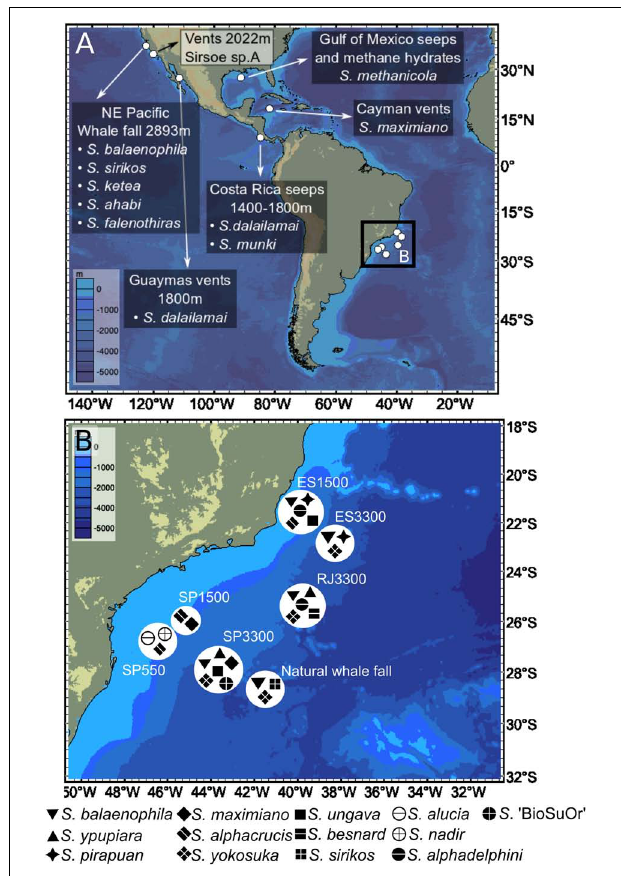
FIGURE 2 | World-wide distribution of Sirsoe species in: (A) Previous records from NE Pacific, Gulf of Mexico, and Caribbean Sea; and (B) New data (this study) from the SW Atlantic Ocean. We omitted the occurrence of Sirsoe hessleri (Blake, 1991) in hydrothermal vents from Mariana back-arc basin (18 ◦ 12.6 (cid:48) N, 144 ◦ 42.4 (cid:48) E, 3640 m).